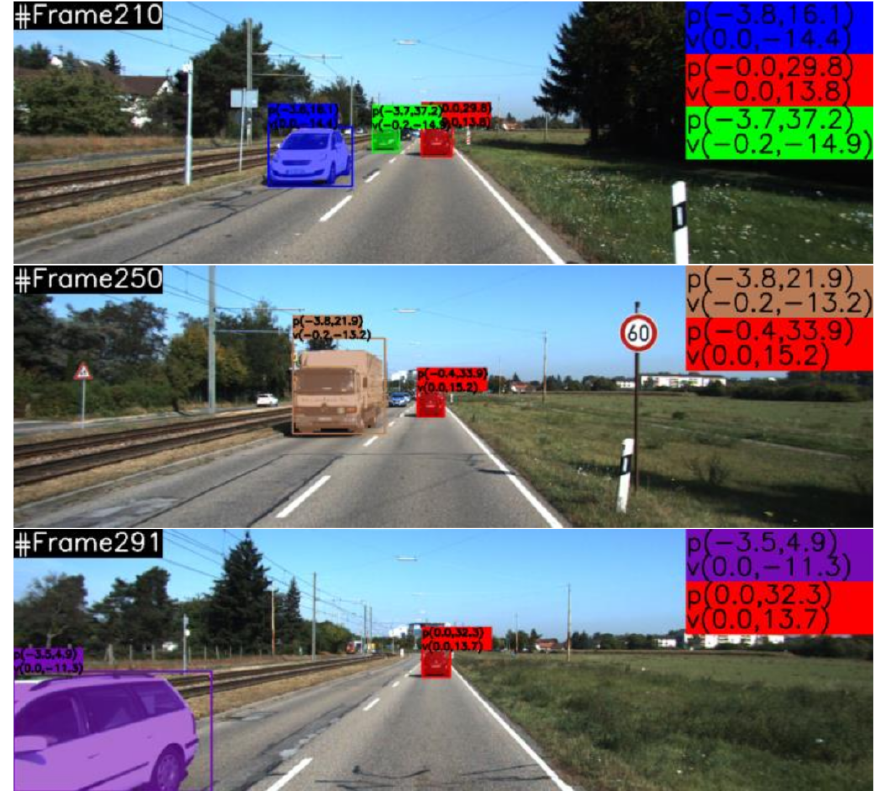
Figure 7. Object segmentation and motion estimate in three frames of Road scene.